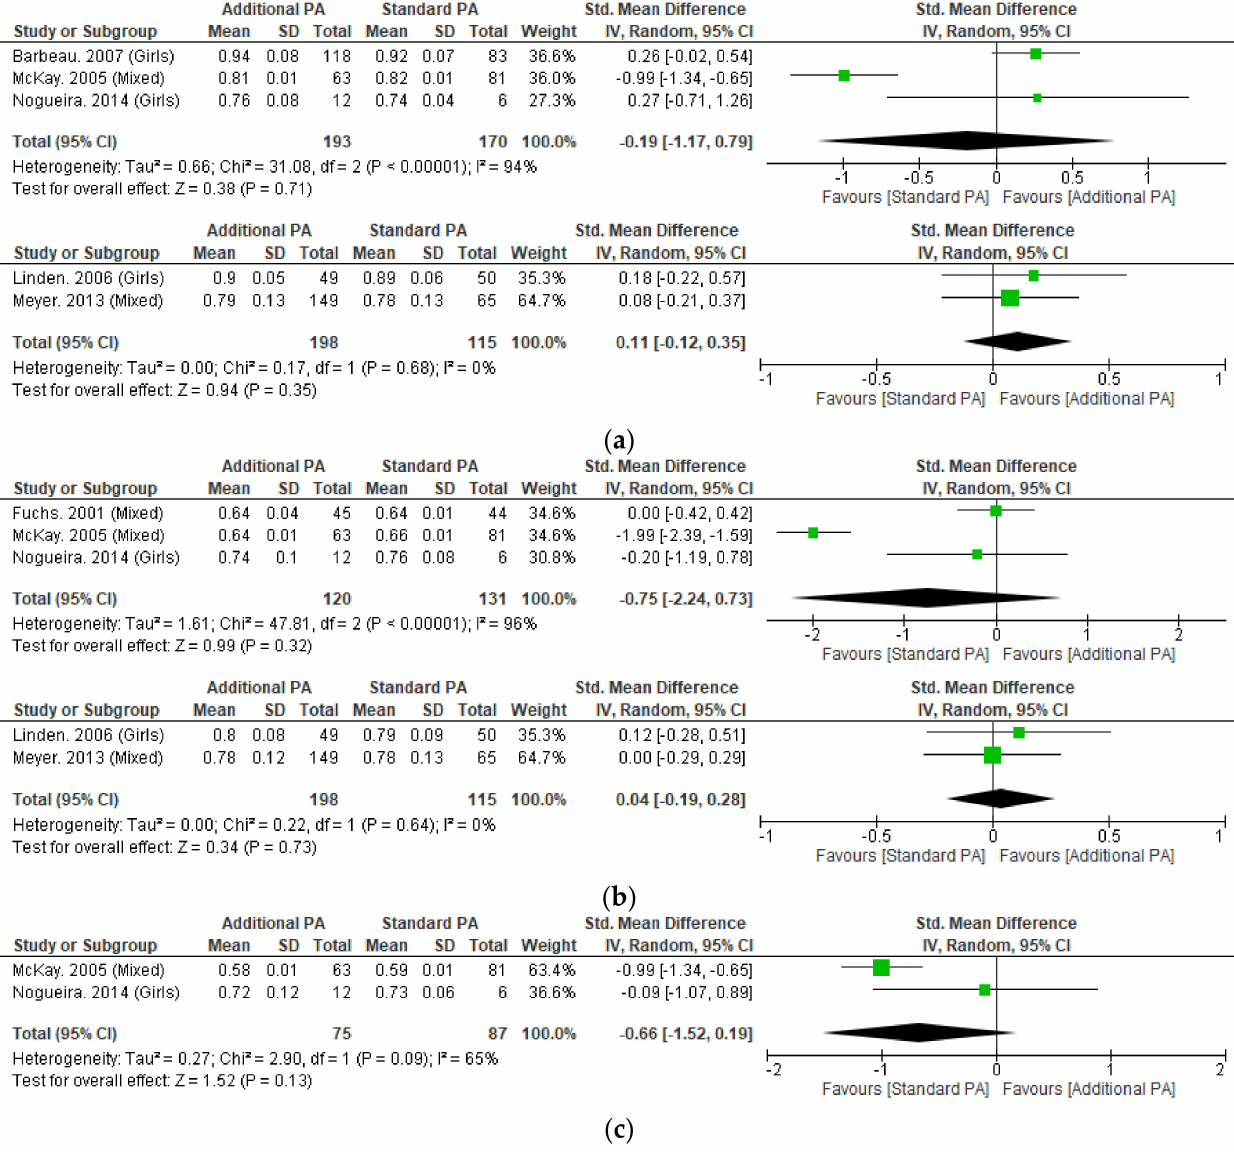
Figure 3. ( a ) Effect of additional exercise interventions on whole body areal bone mineral density. ( Top ) Less than 15 months follow-up, ( Bottom ) 24–48 months follow-up. Legend: PA = Physical Activity, Std = standardised, IV = inverse variance, SD- standard deviation, CI = confidence interval. ( b ) Effect of additional exercise interventions on femoral neck areal bone mineral density. ( Top ) Less than 15 months follow-up, ( Bottom ) 24–48 months follow-up. Legend: PA = Physical Activity, Std = standardised, IV = inverse variance, SD- standard deviation, CI = confidence interval. ( c ). Effect of additional exercise interventions on lumbar spine areal bone mineral density at less than 15 months follow-up. Legend: PA = Physical Activity, Std = standardised, IV = inverse variance, SD- standard deviation, CI = confidence